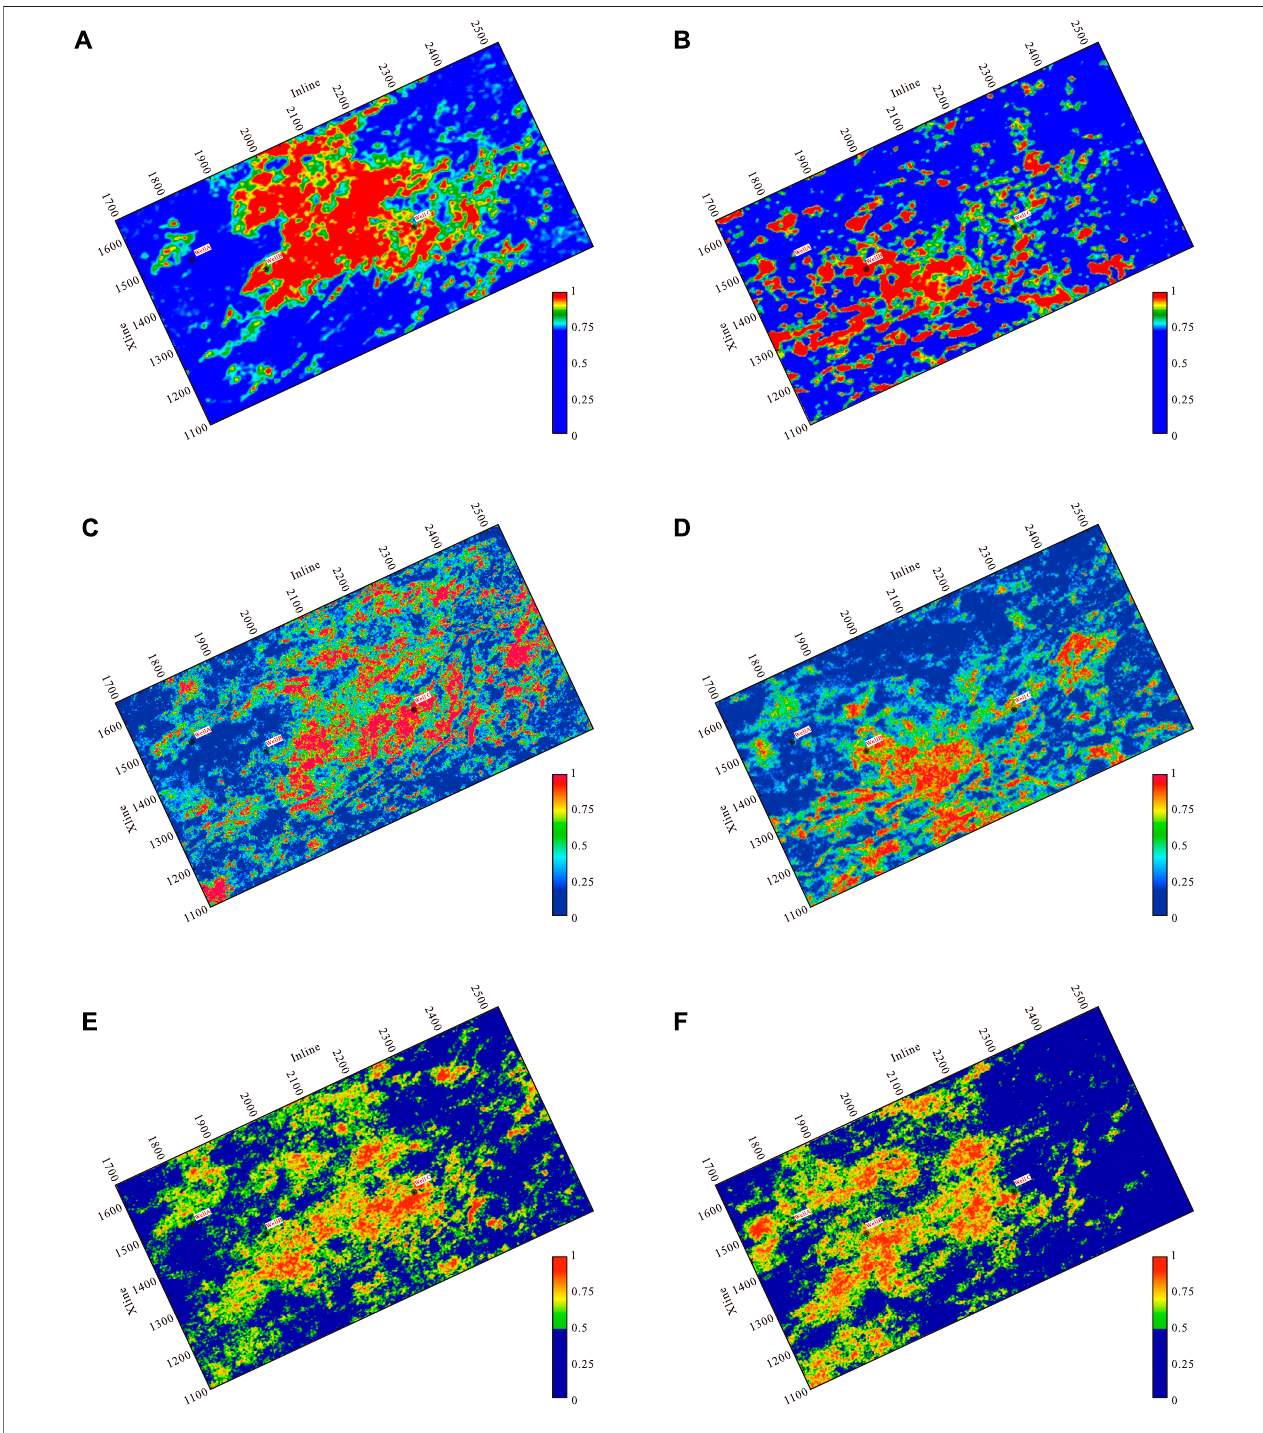
FIGURE 15 | Three dimensional result of hydrocarbon detection. (A) Seismic-print analysis of hydrocarbon detection results for upper member 4 of the Leikoupo Formation (T2 l 41). (B) Seismic-print analysis of hydrocarbon detection results for the lower reservoir section of the fourth member of the Leikoupo Formation (T2 l 43). (C) Prediction results of the dispersion hydrocarbon in depth domain of upper reservoir section 4 of the Leikoupo Formation (T2 l 41). (D) Prediction results of dispersion hydrocarbon in depth domain of lower member 4 of the Leikoupo Formation (T2 l 43). (E) Prediction results of hydrocarbon in DNN of upper member 4 of the Leikoupo Formation (T2 l 41). (F) Prediction results of the hydrocarbon capacity of DNN of lower reservoir Section 4 of the Leikoupo Formation (T2 l 43).